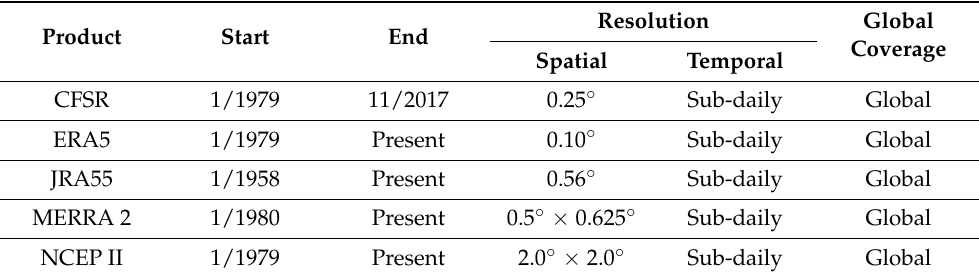
Table 2. The reanalysis products used in this